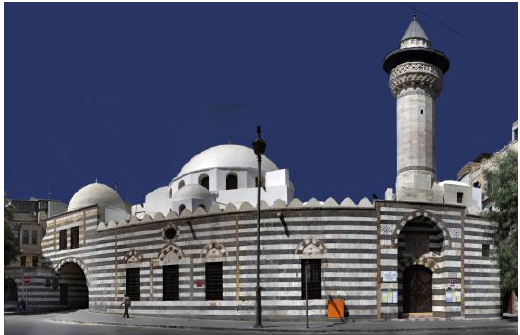
Figure 6 – Damascus, al Darwikiya Mosque. It is the was built by al Darwish, the governor of Damascus in 1578.